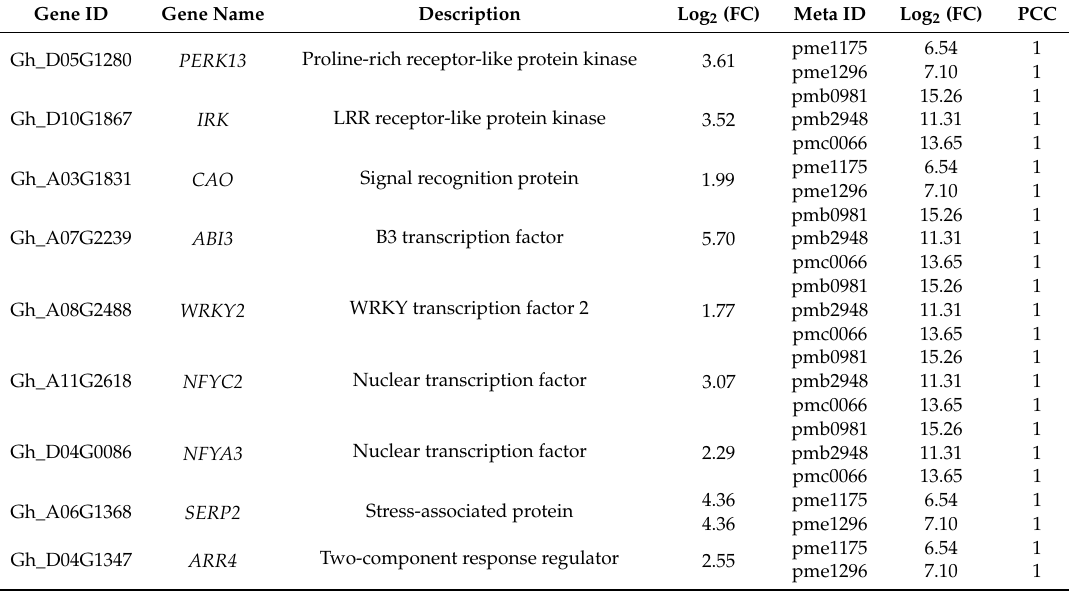
Figure 7. Quadrant diagrams representing association of metabolomic and transcriptomic variation during SE in cotton. ( a ) Overview of metabolomic and transcriptomic variation in PEC vs. NEC; ( b ) overview of metabolomic and transcriptomic variation in GE vs. PEC. The x-axis represents the fold changes in the transcriptome data; the y-axis represents the fold changes in the metabolome data. The black dotted lines represent the differential thresholds. Outside of the threshold lines, there were significant differences in the genes/metabolites, and within the threshold lines are shown the unchanged genes/metabolites. Each point represents a gene/metabolite. Black dots represent the unchanged genes/metabolites; green dots represent differentially accumulated metabolites with unchanged genes; red dots represent differentially expressed genes with unchanged metabolites; blue dots represent both differentially expressed genes and differentially accumulated metabolites. NEC, nonembryogenic staged calli; PEC, primary embryogenic calli; GE, initiation staged embryos with globular-like enriched. Table 4. Significant representative differentially expressed genes (DEGs) involved in purine metabolism during embryogenic differentiation (PEC vs. NEC).